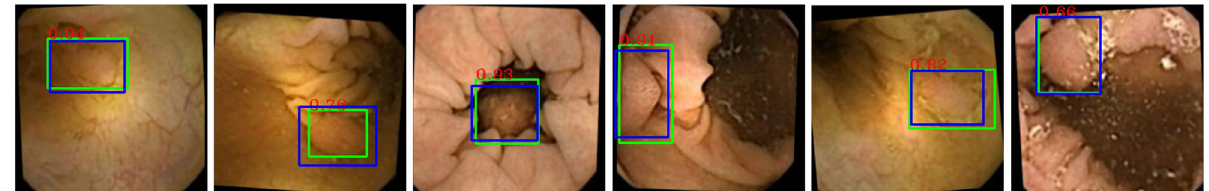
Figure 4. Examples of the performance of polyp detection